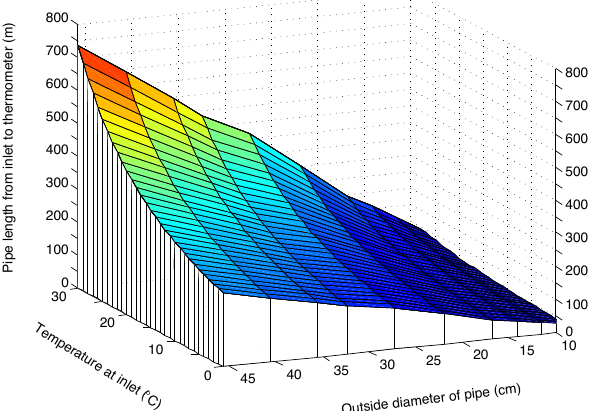
Fig. A4. Pipe length required for intake seawater to warm by 0.2 ◦ C given an engine room air temperature of 50 ◦ C and flow velocity of 1ms − 1